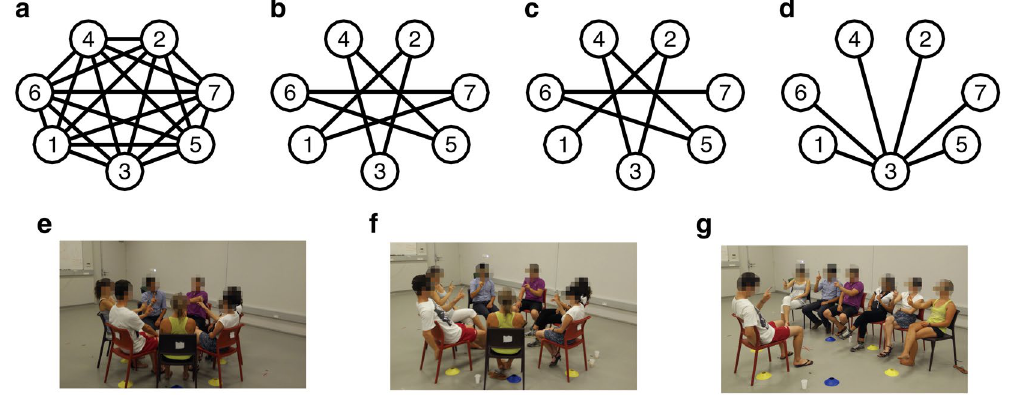
Figure 2. Interaction patterns implemented through visual coupling in the experiments. ( a ) Complete graph: each participant can see the movements of all the others. ( b ) Ring graph: each participant can see the movements of only her/his two partners . ( c ) Path graph: similar to the Ring graph configuration, but agents 1 and 7, defined as external , have only one partner (2 and 6, respectively) and consequently are not visually coupled. ( d ) Star graph: agent 3, defined as central , can see the movements of all the others, defined as peripheral , who in turn see the movements of only the central player. The other panels show the actual arrangement of the players during the experiment [( e ) for the Complete graph, ( f ) for Ring and Path graphs, and ( g ) for the Star